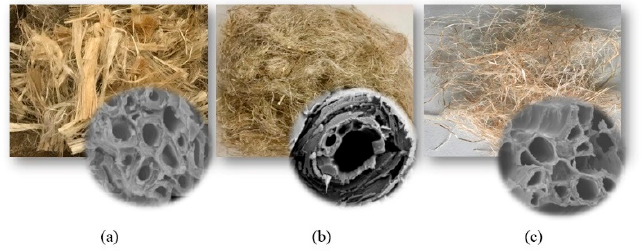
Figure 3. Short ( a ) kenaf, ( b ) flax and ( c ) hemp fibers and cross section of a fiber bundle (modified illustration [6]).